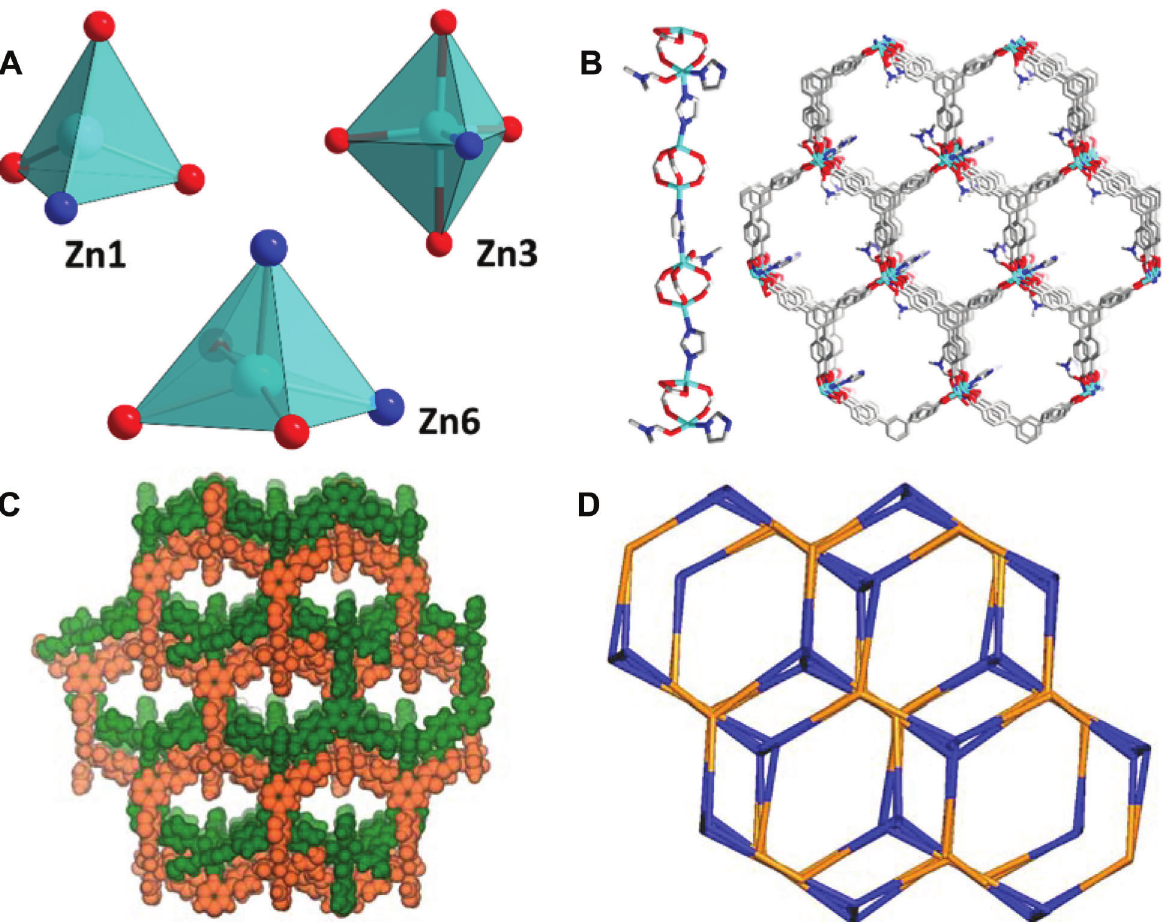
Figure 3. A , View of the coordination modes of Zn(II) ions in 2 ; B , view of 1D secondary building unit chains and the 3D pillared framework; C , view of the 2-fold interpenetrated 3D framework of 2 ; D , the hms -type (3,5)-connected topology for